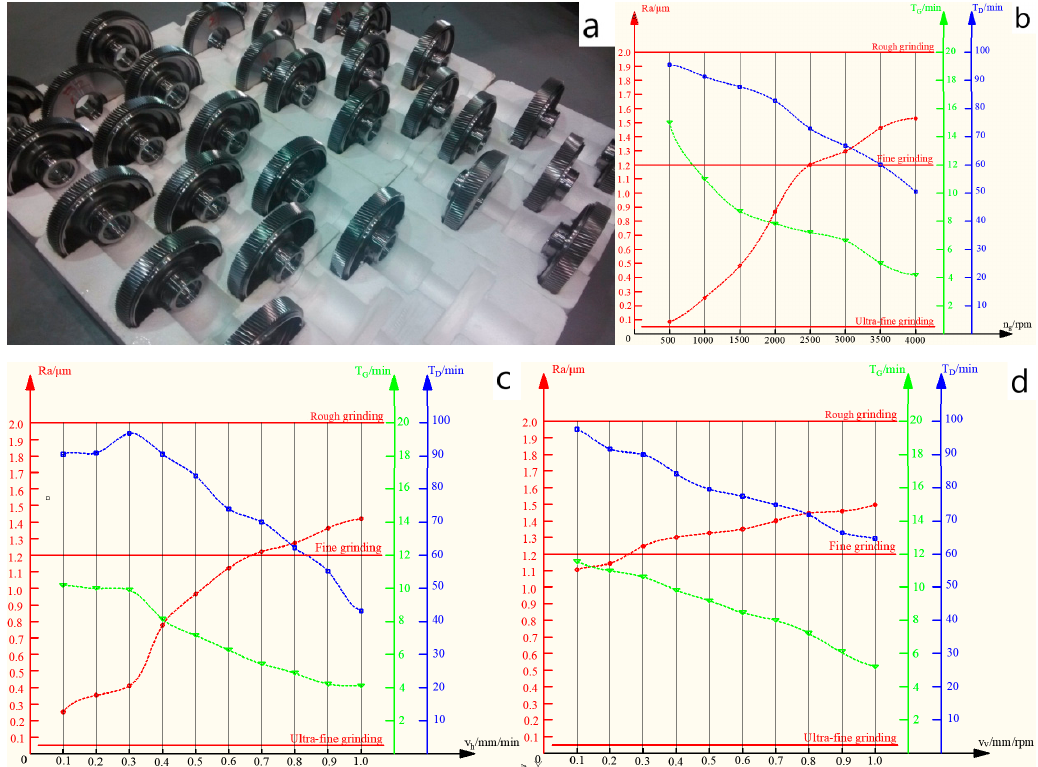
Figure 6. ( a ) Experiment processed gear; analysis of the impact of the ( b ) Grinding wheel speed; ( c ) Feed rate; and ( d ) Grinding wheel frame speed on surface roughness, efficiency, and wheel life.